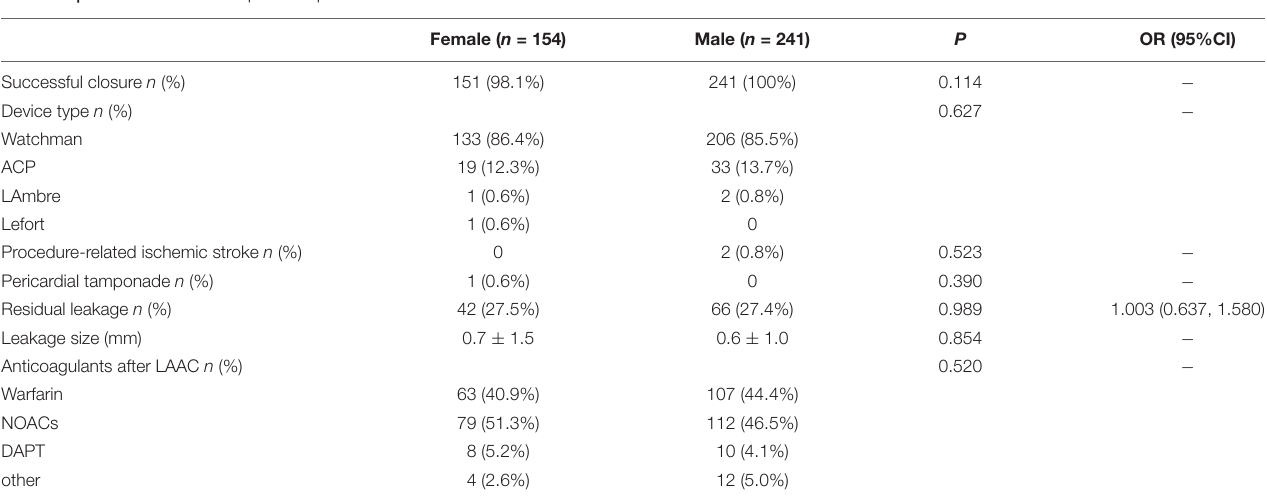
TABLE 2 | Procedure and in-hospital complications